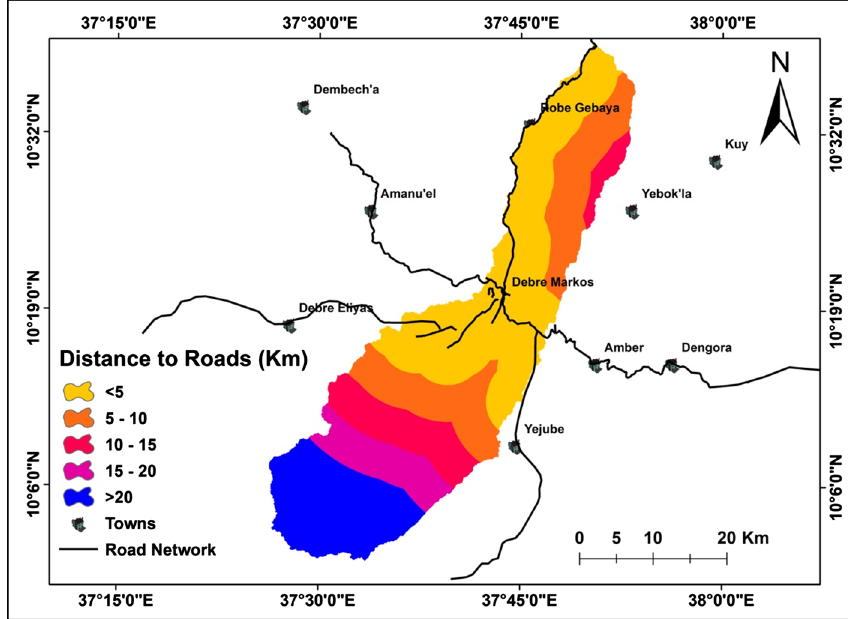
Fig. 10 Distance from road network map of the study area